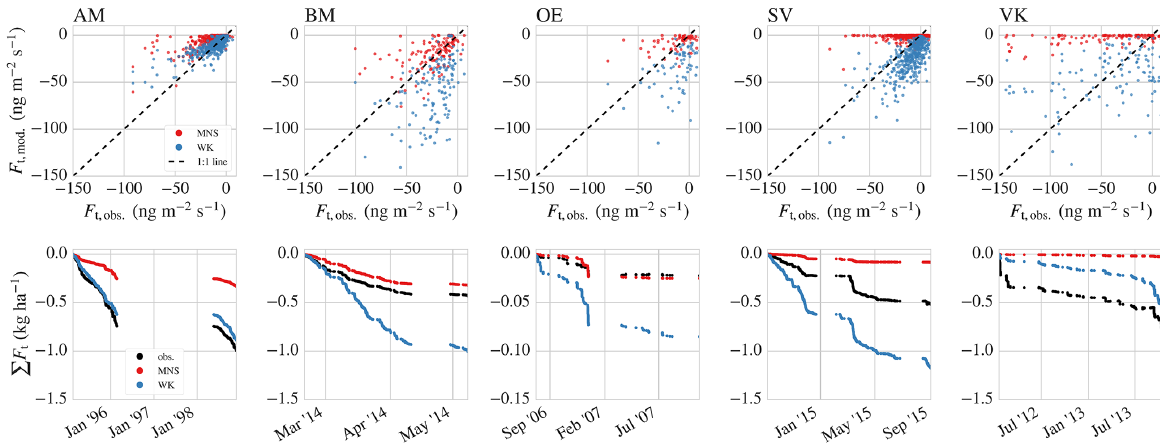
Figure 3. Measured and modeled ammonia dry deposition fluxes ( F t ) during near-neutral or slightly stable nighttime conditions. (Upper row) Modeled vs. measured 6h median flux densities. (Lower row) Cumulative fluxes. obs. = observations; MNS = Massad et al. (2010); WK = Wichink Kruit et al. (2010). Refer to the text for site descriptors. Note the different scaling of the axes.